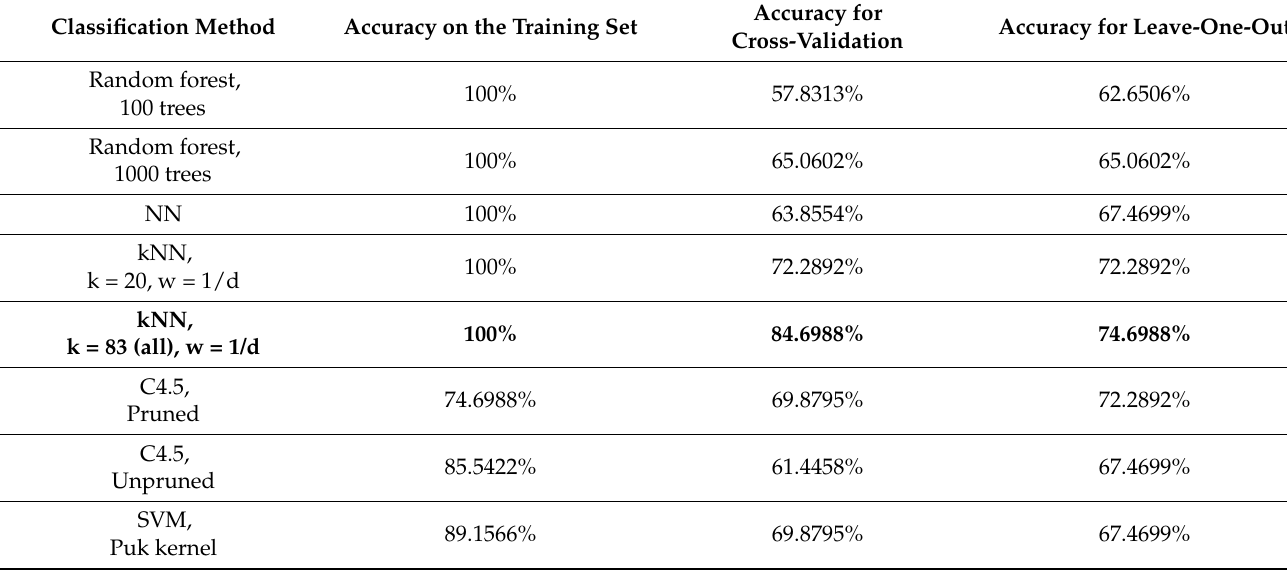
Table 8. Classification results when only the latest record for each patient is retained.